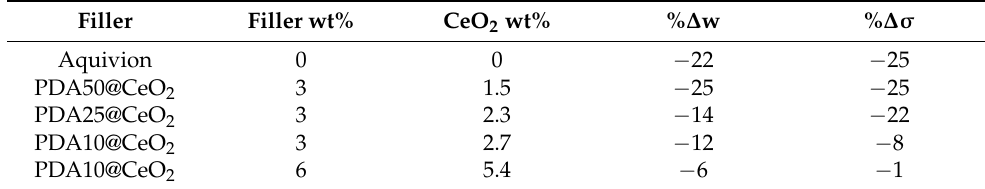
Table 2. Dry weight and conductivity percentage changes (% ∆ w and % ∆ σ ) for bare Aquivion and Aquivion composite membranes loaded with PDAx@CeO 2 after the Fenton test. Filler Filler wt% CeO 2 wt% % ∆ w